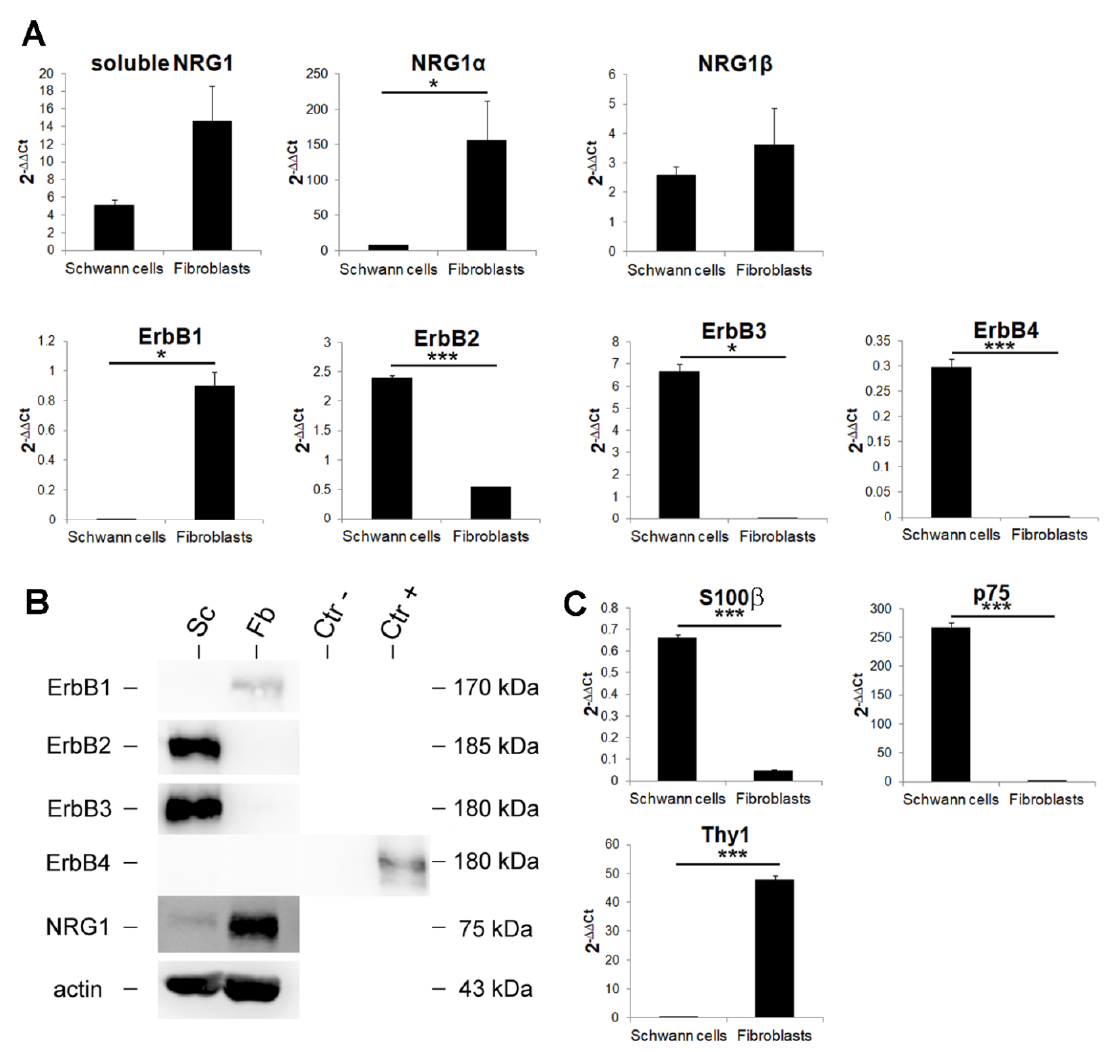
Figure 3. Nerve fibroblasts express high levels of soluble NRG1. ( A ) Quantitative analysis of the NRG1 / ErbB system expression in primary cultures of Schwann cells and nerve fibroblasts. Relative quantification (2 − ∆∆ Ct ) of di ff erent NRG1 isoforms (soluble, α , β ), ErbB1, ErbB2, ErbB3, and ErbB4 was evaluated by qRT-PCR. ( B ) Western blot analysis of the NRG1 / ErbB system. Proteins were extracted from primary cultures of Schwann cells (Sc) and nerve fibroblasts (Fb), separated on 8% acrylamide-bis-acrylamide gels and probed with antibodies for ErbB1, ErbB2, ErbB3, and ErbB4; for NRG1, an antibody recognizing the C terminus fragment was used. Actin was used as a loading control. Size markers are indicated on the right. Neural progenitor cells stably expressing ErbB4 or mock cells were used respectively as positive (Ctr + ) and negative (Ctr-) controls for ErbB4. ( C ) Quantitative expression analysis of Schwann cell and nerve fibroblast markers. Relative quantification (2 − ∆∆ Ct ) of S100 β and p75 (Schwann cell markers) and Thy1 (fibroblast marker) was evaluated by qRT-PCR to ensure the purity of the primary cultures. For panel A and C, the geometric average of housekeeping genes ANKRD27 and RICTOR was used to normalize data. All data were calibrated to healthy median nerves, whose expression, not shown, is = 1. Values in the graphics are expressed as mean + SEM ( n = 3 for each group). For normally distributed data with comparable variances two-tailed Student’s t -test was carried out, while for nonparametric data Mann–Whitney U-test was used; * p ≤ 0.05, *** p ≤ 0.001. The identity of both cell types was confirmed by qRT-PCR using specific biomarkers: S100 β and p75 for Schwann cells and Thy1 for fibroblasts (Figure